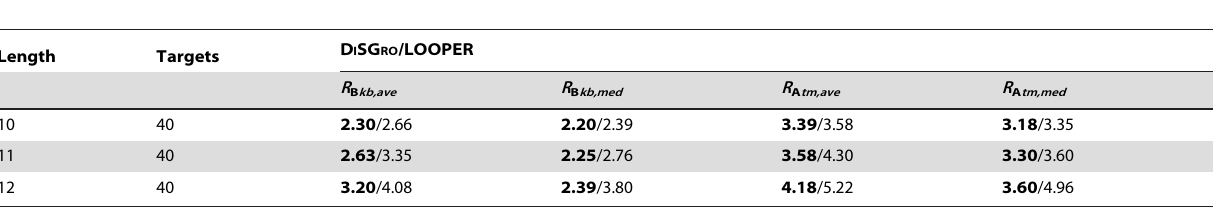
Table 4. Comparison of accuracy of modeled loops using the original Fiser data set of loops with 10 – 12 residues.